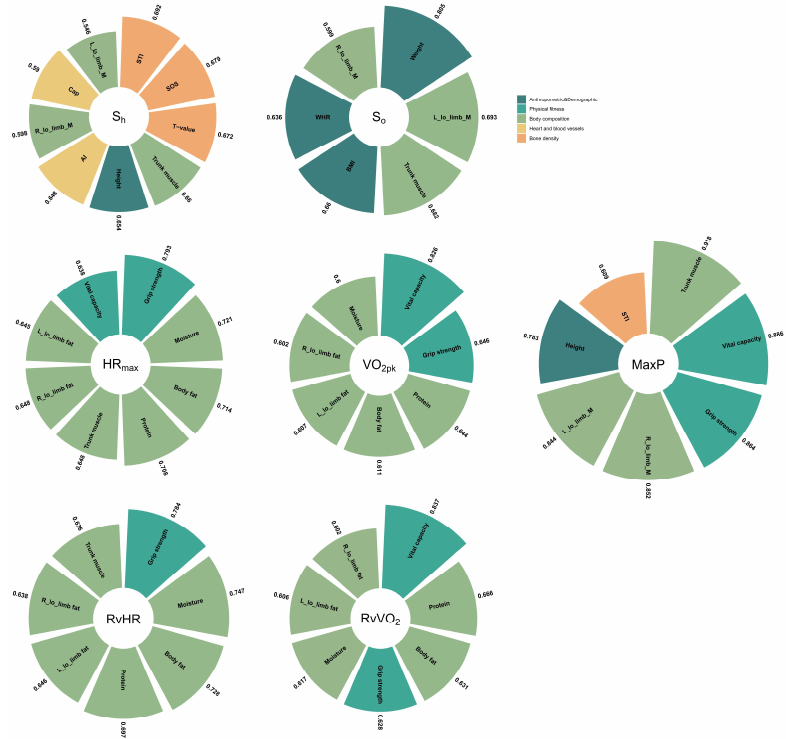
Figure 3. Details of the Non-In data with the relationships ( p < 0.001) to each of the exercise data for the participants older than 40. The different colors represent the specific categories to which the data belong. The numbers outside the sector represent their correlation values.